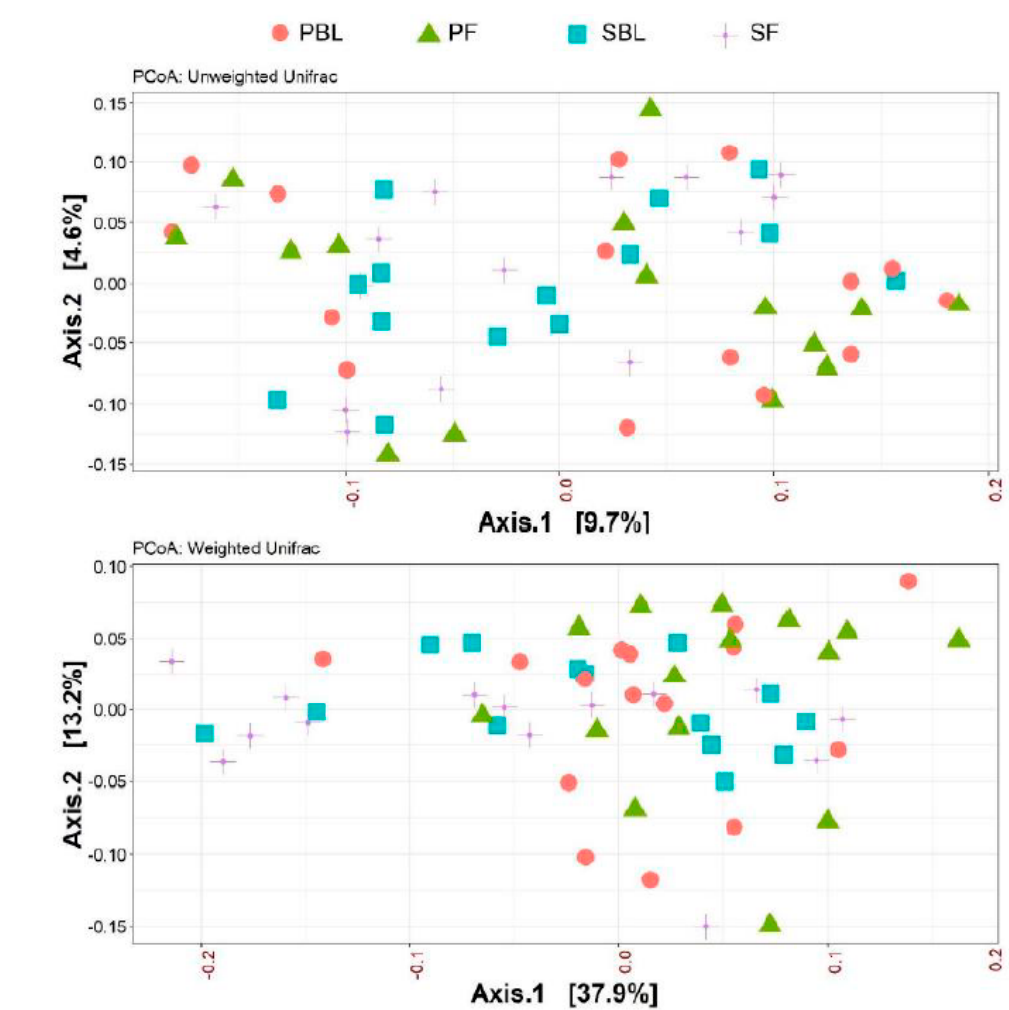
Figure 3. Beta-diversity between placebo group and spice group. Principal coordinate analysis (PCoA) plots of all fecal samples from 29 subjects in two groups at baseline and 2 week follow up. Red circle and green triangle represent participants in PBL and PF, blue square and purple cross represent participants in mixed SBL and SF, respectively. ( A ) Unweighted UniFrac. ( B ) Weighted UniFrac. Axis 1, principal coordinate 1; axis 2, principal coordinate 2. PBL, placebo group at baseline; PF, placebo group at follow up; SBL, spice group at baseline; and SF, spice group at follow up.